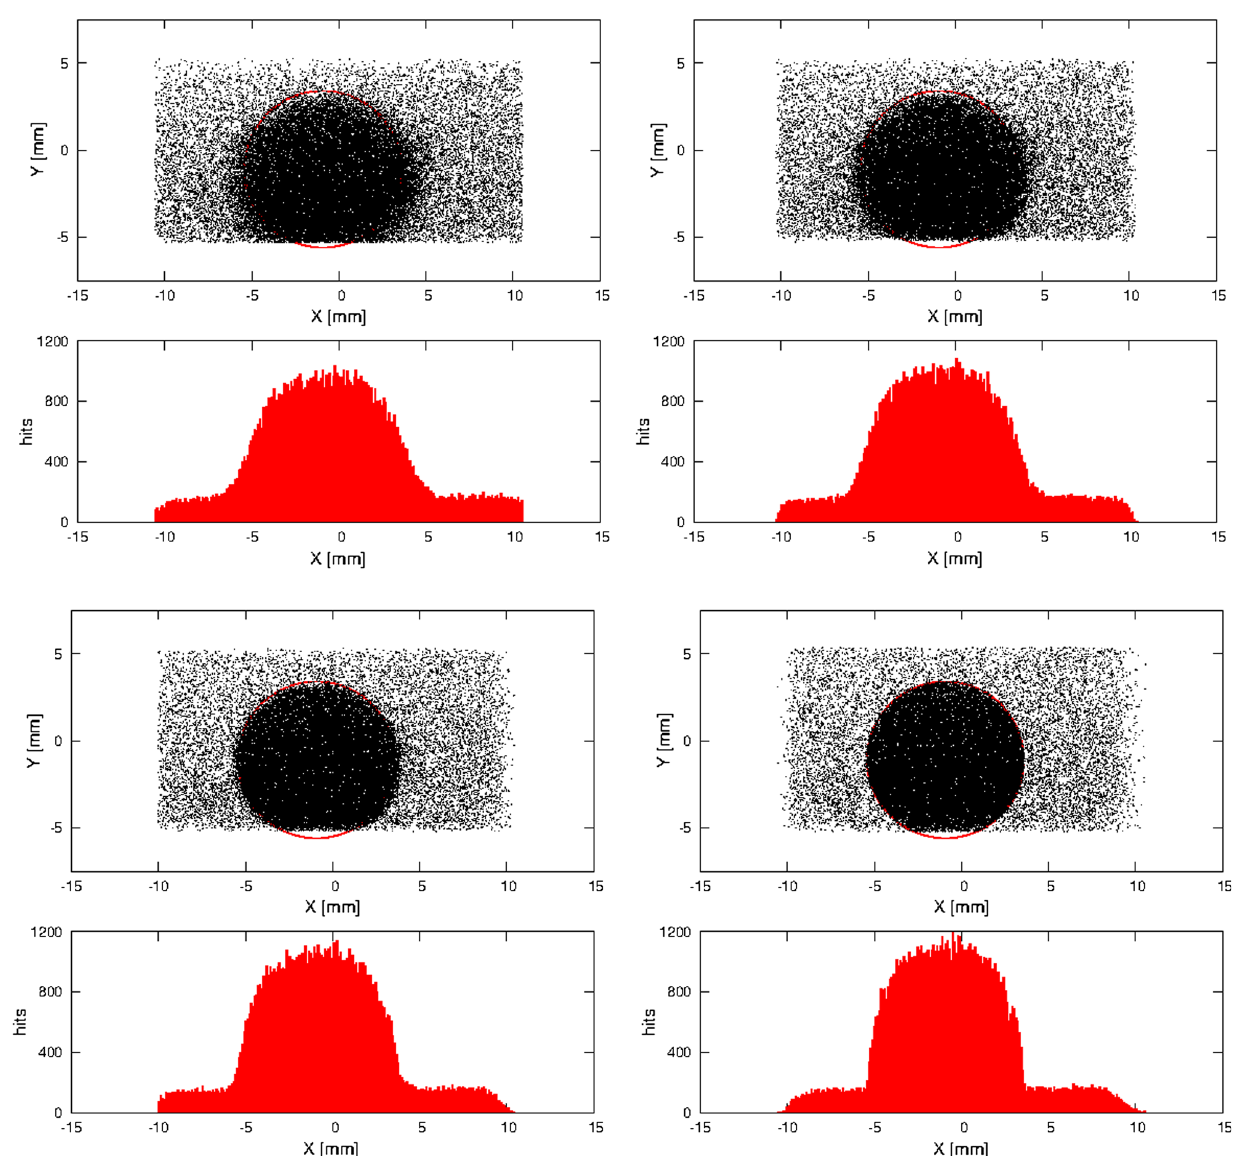
Fig. 10 Distributions of telescope hits assigned to a track in the X–Y plane after data processing, (top part of figure) together with the pro- jection on the X axis (bottom part of figure). The red circle represents